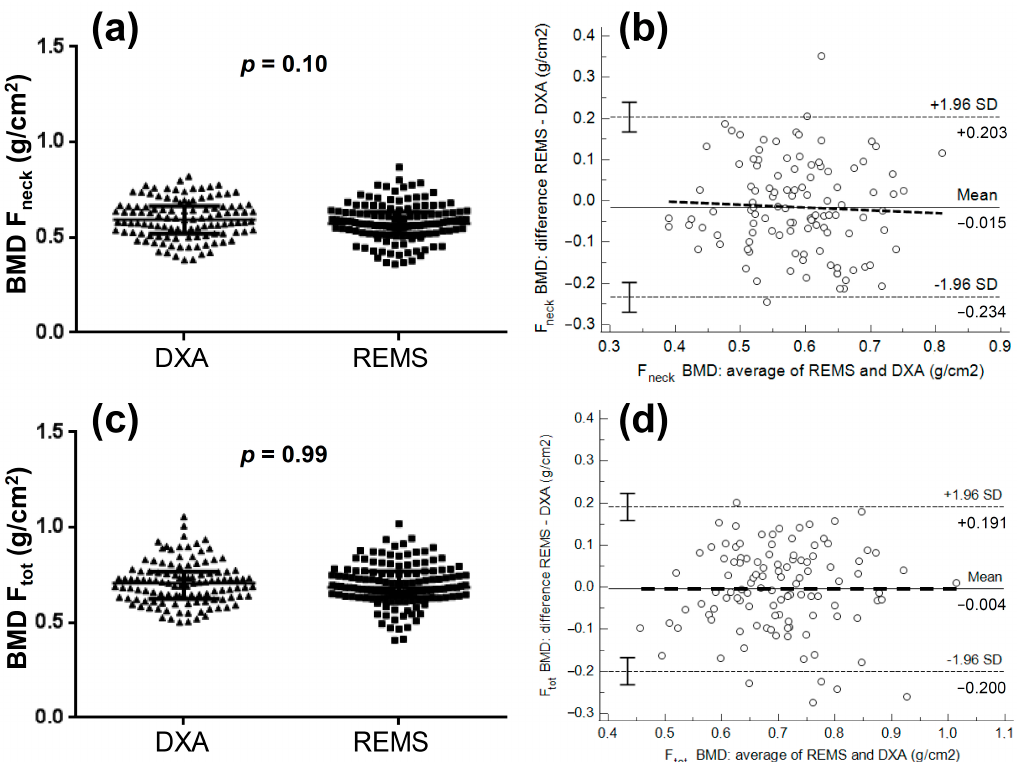
Figure 2. Comparisons of femoral neck bone mineral density (BMD F neck : panel ( a )) and total femur bone mineral density (BMD F tot : panel ( c )) between DXA and REMS and relative Bland-Altman plots (panels ( b – d )) in patients with primary osteoporosis.